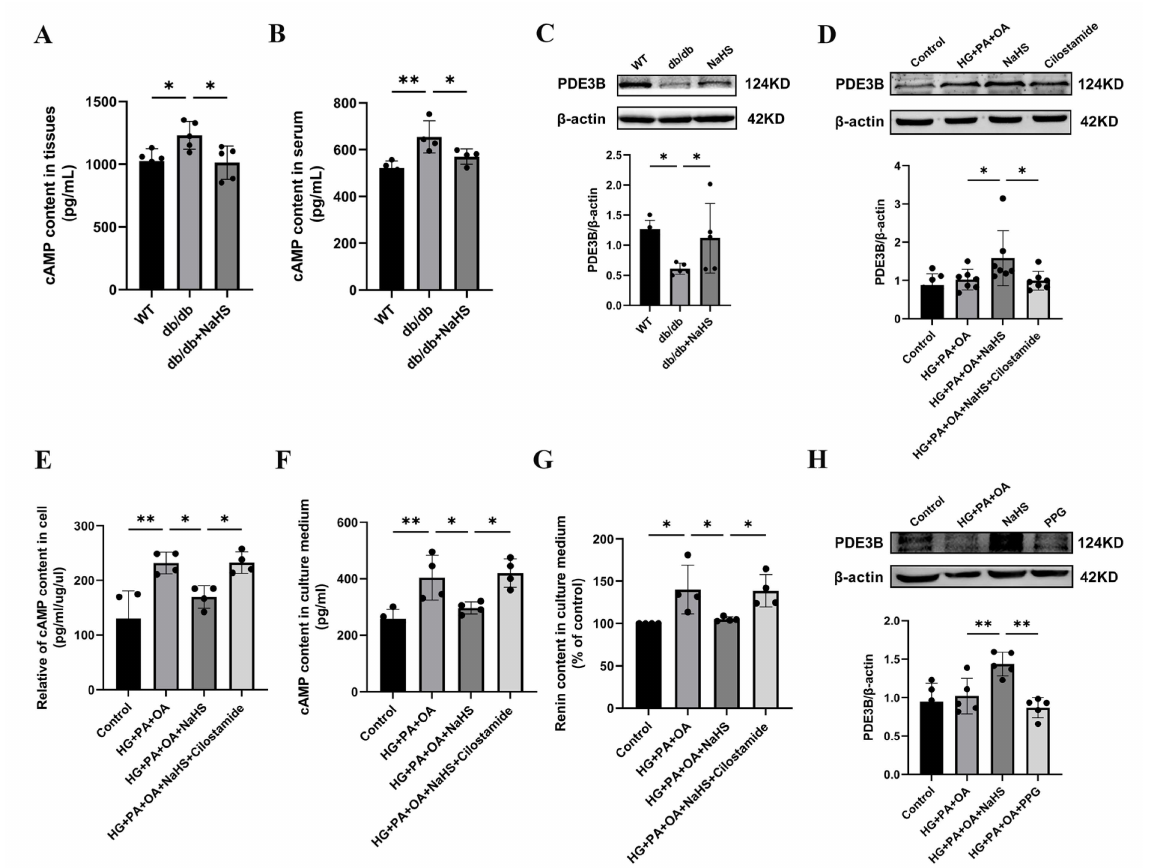
Figure 4. Exogenous H 2 S inhibited RAAS activation by modulating the PDE3B-cAMP pathway. ( A , B ) cAMP content in kidney tissues ( n = 5) and serum of db/db mice ( n = 4) assessed by an ELISA kit. ( C , D ) PDE3B expression levels in the kidney tissues ( n = 5) and JG cells ( n = 7) were detected by Western blotting. After treatment with cilostamide (10 µ M) in JG cells, PDE3B expression level was detected. cAMP content in the intracellular ( E ) and cell culture medium ( F ), and renin content in cell culture medium ( G ) were assessed by ELISA kits ( n = 4). ( H ) Western blot analysis of PDE3B expression level in JG cells treated with PPG ( n = 5). * p < 0.05, ** p < 0.01. PDE3B, phosphodiesterases